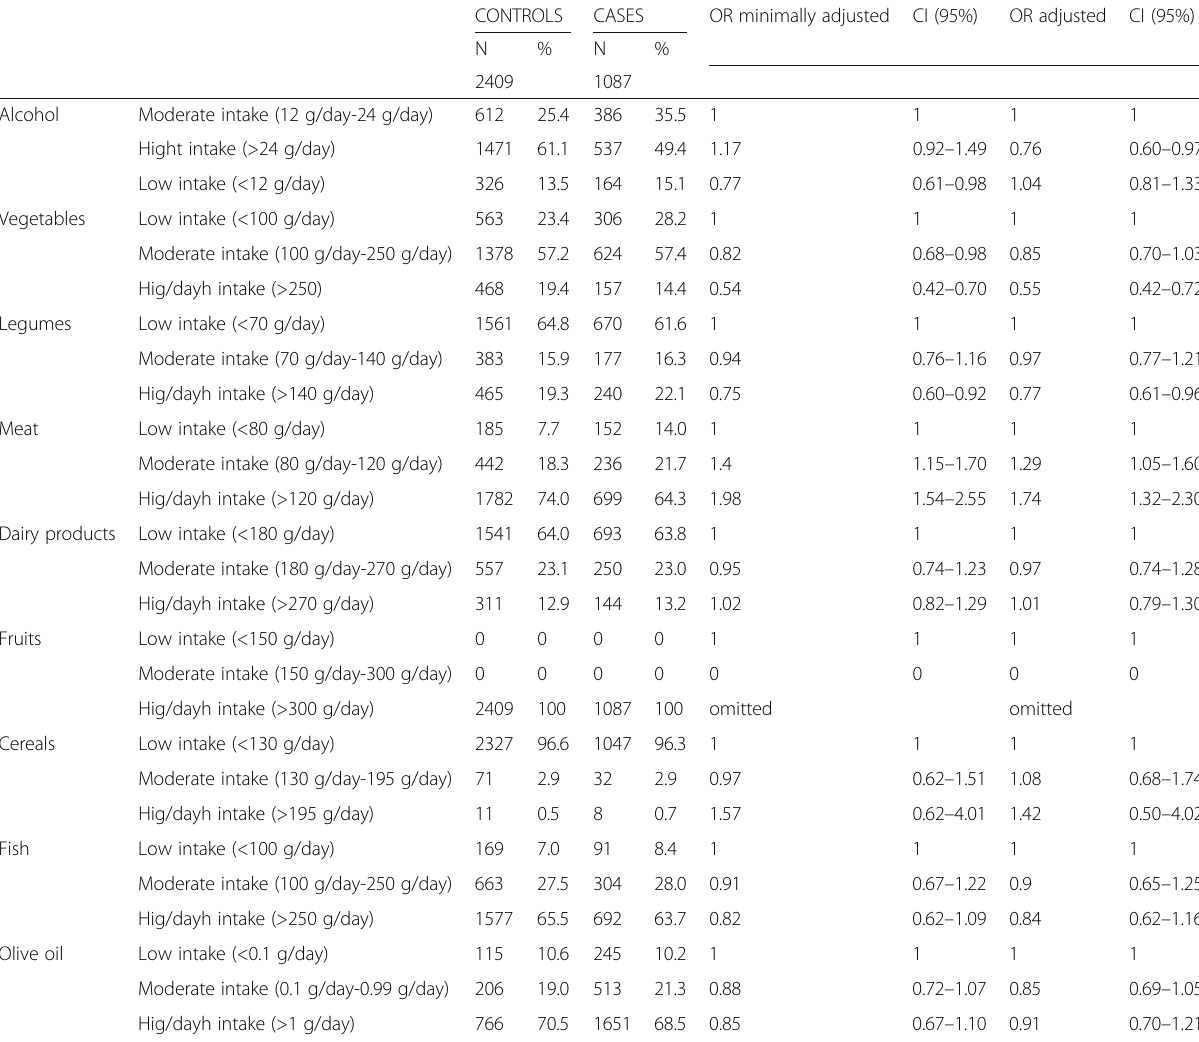
Table 2 Association between intake levels of food components in the Mediterranean diet anc case (affection) status. The cut points are based on the score criteria for Sofi ’ s Mediterranean diet pattern